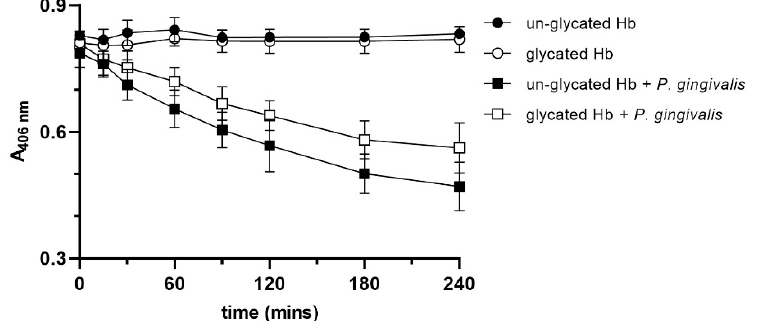
Figure 4. Heme release from hemoglobin after incubation with P. gingivalis . Absorbance of the samples was measured at 406 nm (A 406nm ), and the heme release is shown as the decrease in A 406nm with time. Control samples did not include P. gingivalis . The data are expressed as mean ± SD from three replicates.